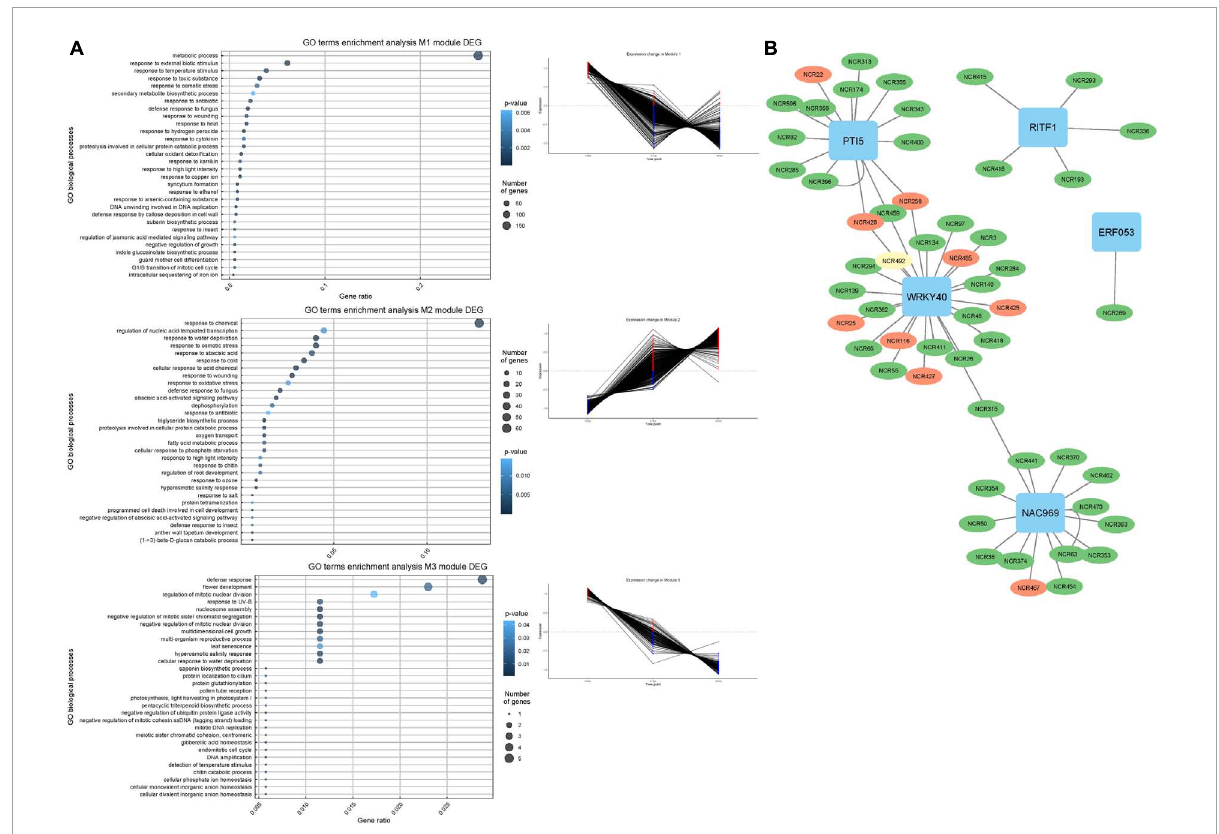
FIGURE10 (A) Co-expression gene modules and their expression pattern identified using CEMiTool at 12, 21, and 28 dpi and biological process GO enrichment of the differentially expressed genes in detected co-expression modules. (B) NCR gene regulatory network based on gene expression data. NCR genes with a maximum expression at 12 dpi are colored green. NCR genes with a maximum expression at 21 dpi are colored yellow. NCR genes with a maximum expression at 28 and 42 dpi are colored